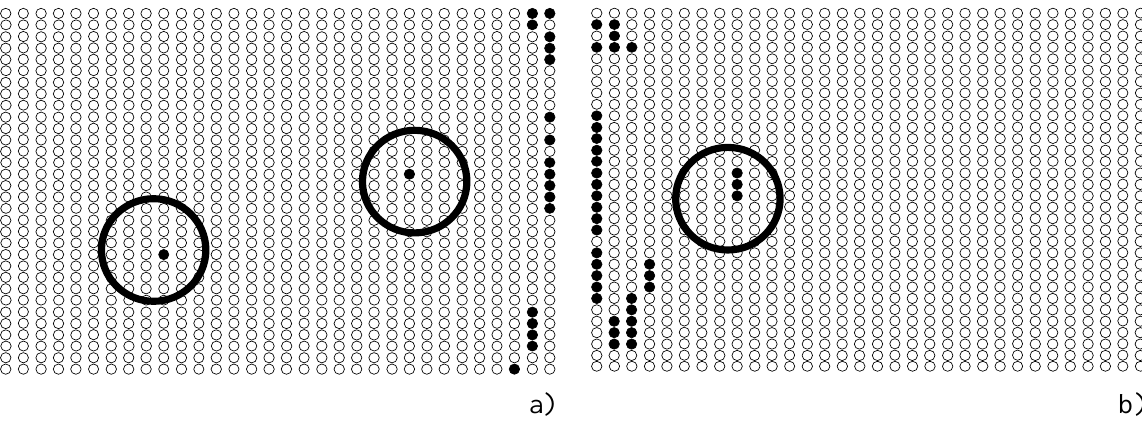
Fig. 14. ANN outputs for the composite panel (black: defected points). a) between layers 1–2 and 3–4; b) between layers